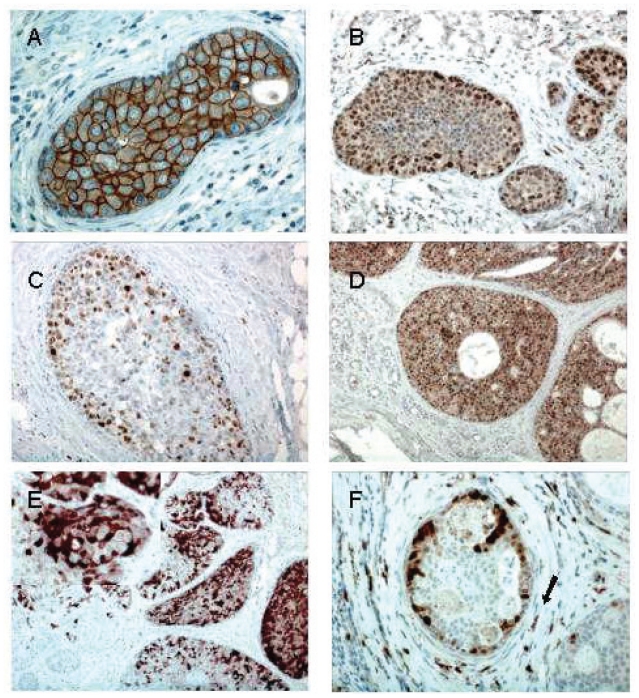
2A- Positive membranous immunostain for HER2/neu oncoprotein in high grade DCIS (clone: CB11, X200) 2B- Positive nuclear immunostain for p21in 50% of the cells in intermediate grade DCIS. Note the variable intensity of stains. (x100) 2C- Positive nuclear immunostain for MIB1 in 30% of the cells in high grade DCIS. (x100) 2D- Positive nuclear immunostain for cyclin D1 in 100% of the cells in low grade, cribriform DCIS. (x50) 2E- Positive nuclear and/or cytoplasmic immunostain for psoriasin (S100A7). The staining is heterogeneous, with negative and positive areas of DCIS. (x50) 2F- Positive nuclear and/or cytoplasmic immunostain for calgranulin (S100A9). The staining is heterogeneous with some negative and some strongly positive cells within the same focus of DCIS. Note the positive reaction in the granulocytes (arrow, x200).